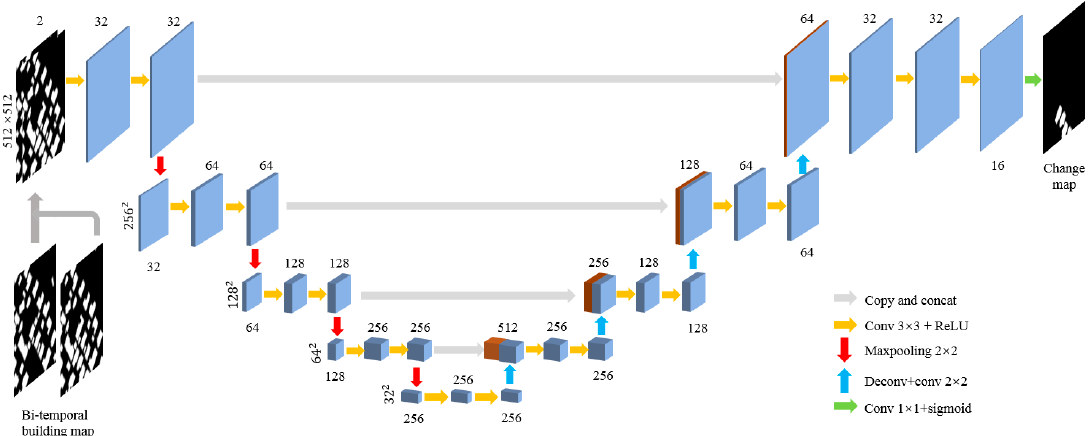
Figure 5. The building change detection network.